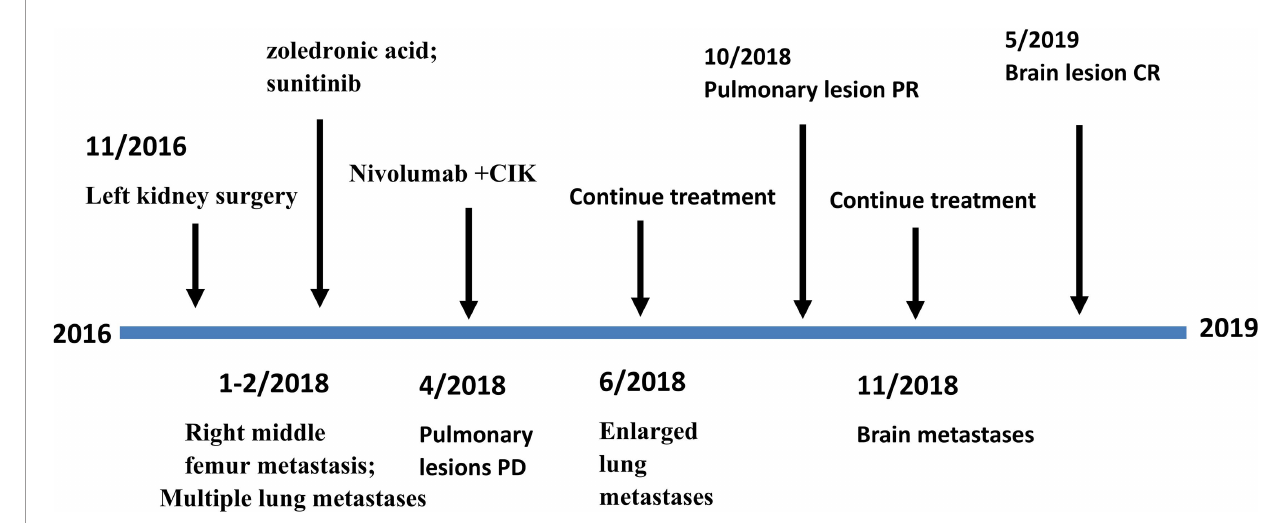
FIGURE 3 | Timeline of the patient